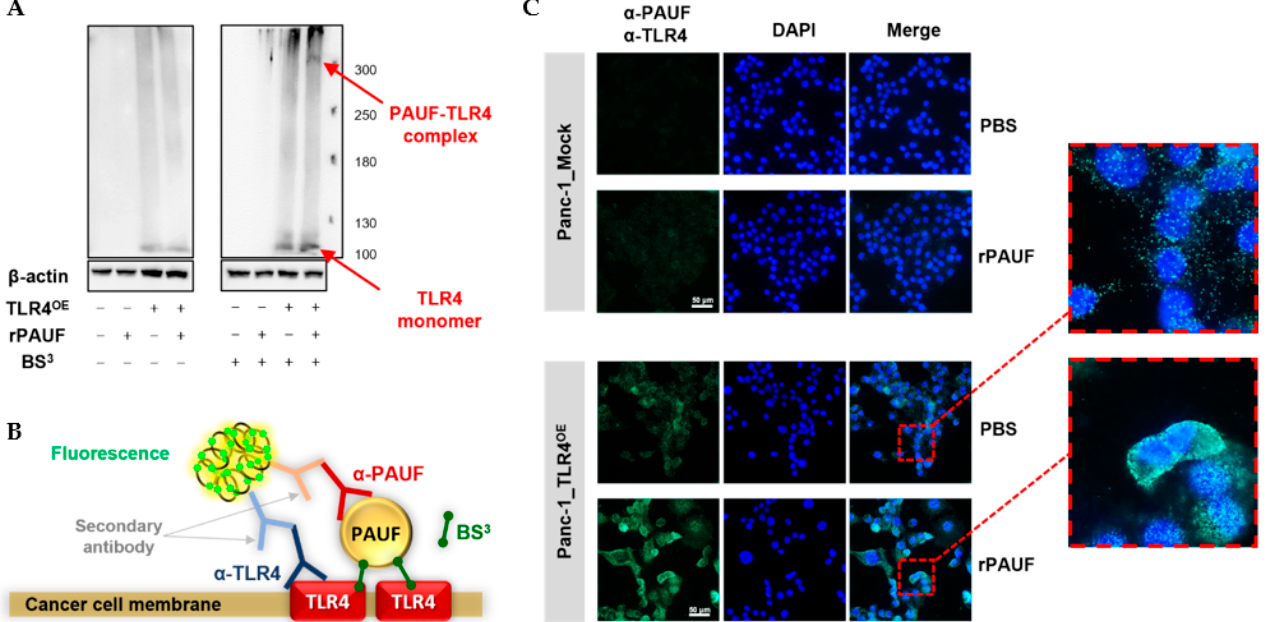
Figure 5. PAUF binds directly to TLR4 expressed on pancreatic cancer cells. ( A ) A PAUF-TLR4 complex was detected in Panc-1_TLR4 OE cells using Western blot after treatments of recombinant PAUF (rPAUF, 1 µg/mL) and crosslinker (BS 3 ). ( B ) Schematic illustration of proximity ligation assay (PLA). ( C ) PLA was performed in Panc-1_Mock and Panc-1_TLR4 OE cells with or without treatments of rPAUF. Extended focus images for framed areas are shown. Scale bars, 50 µm.